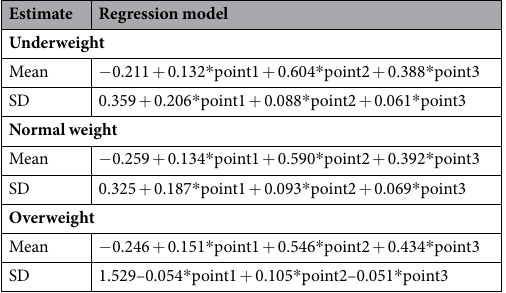
Table 3. Regression models according to pre-pregnancy BMI categories. Note: Using equations of mean and SD one can compute any desired percentiles using relation P th percentile = mean + K * SD, where K is normal equivalent deviate (z score) corresponding to particular percentile, for example, K = 1.64 for 95th percentile and − 1.64 for 5th percentile, and SDs in this equation are predicted estimates from the regression model. For example, to calculate GWG at 24 weeks for normal weight pregnant woman: p50 for GWG = ( − 0.259 + 0.134 * 5 + 0.590 * 10 + 0.392 * 0) + (0 × (0.325 + 0.187 * 5 + 0.093 * 10 + 0.069 * 0)). p5 for GWG = ( − 0.259 + 0.134 * 5 + 0.590 * 10 + 0.392 * 0) + ( − 1.64 × (0.325 + 0.187 * 5 + 0.093 * 10 + 0.069 * 0)). p95 for GWG = ( − 0.259 + 0.134 * 5 + 0.590 * 10 + 0.392 * 0) + (1.64 × (0.325 + 0.187 * 5 + 0.093 * 10 + 0.069 * 0)). Abbreviations: BMI, body mass index; SD, standard